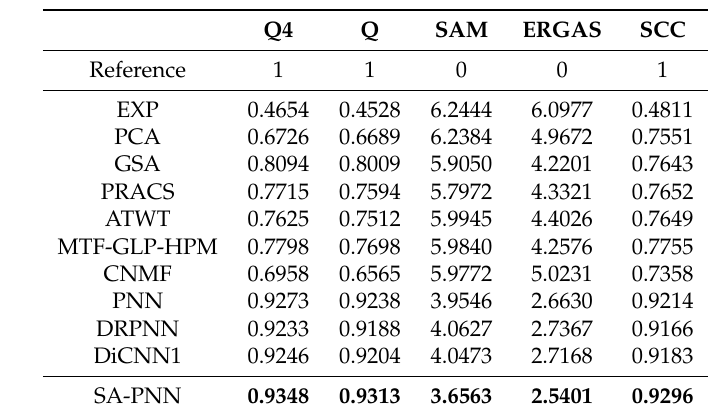
Table 3. Quality indexes at reduced resolution on a 256 × 256 sub-scene of the IKONOS dataset (best result is in